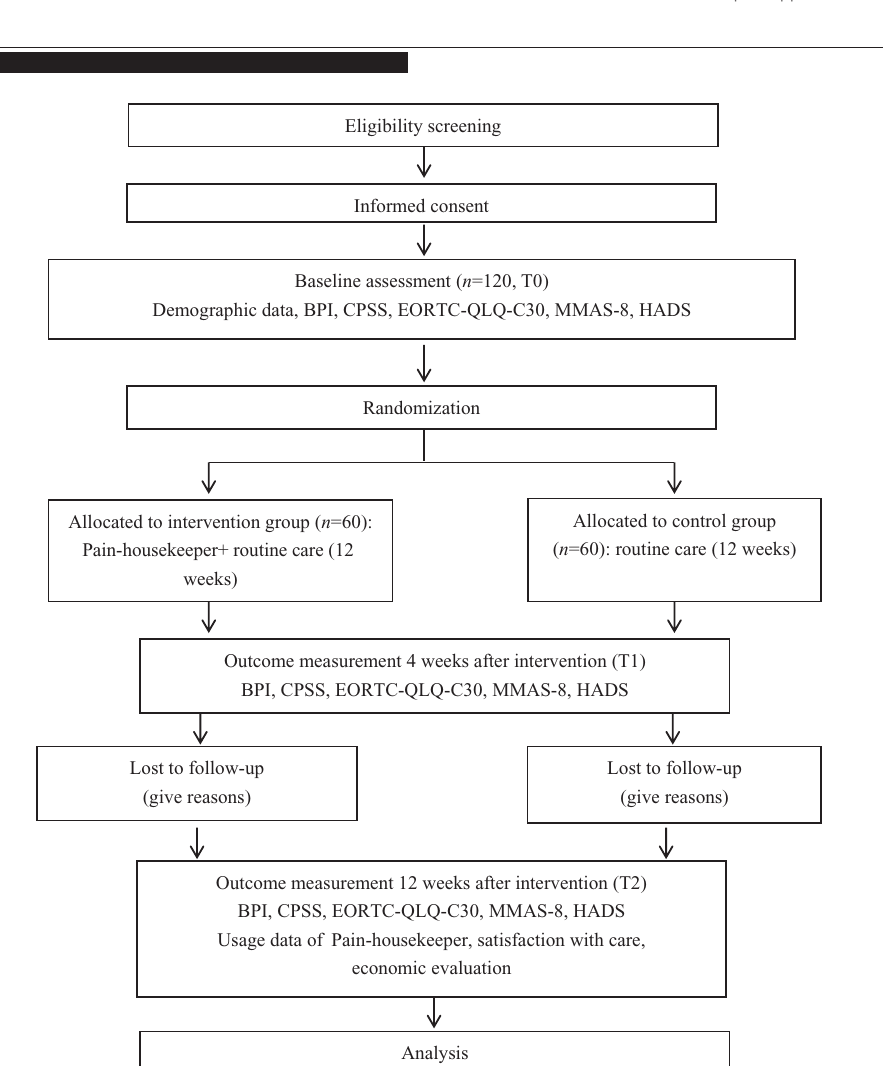
Figure 2. CONSORT flowchart of the study adapted from Schulz et